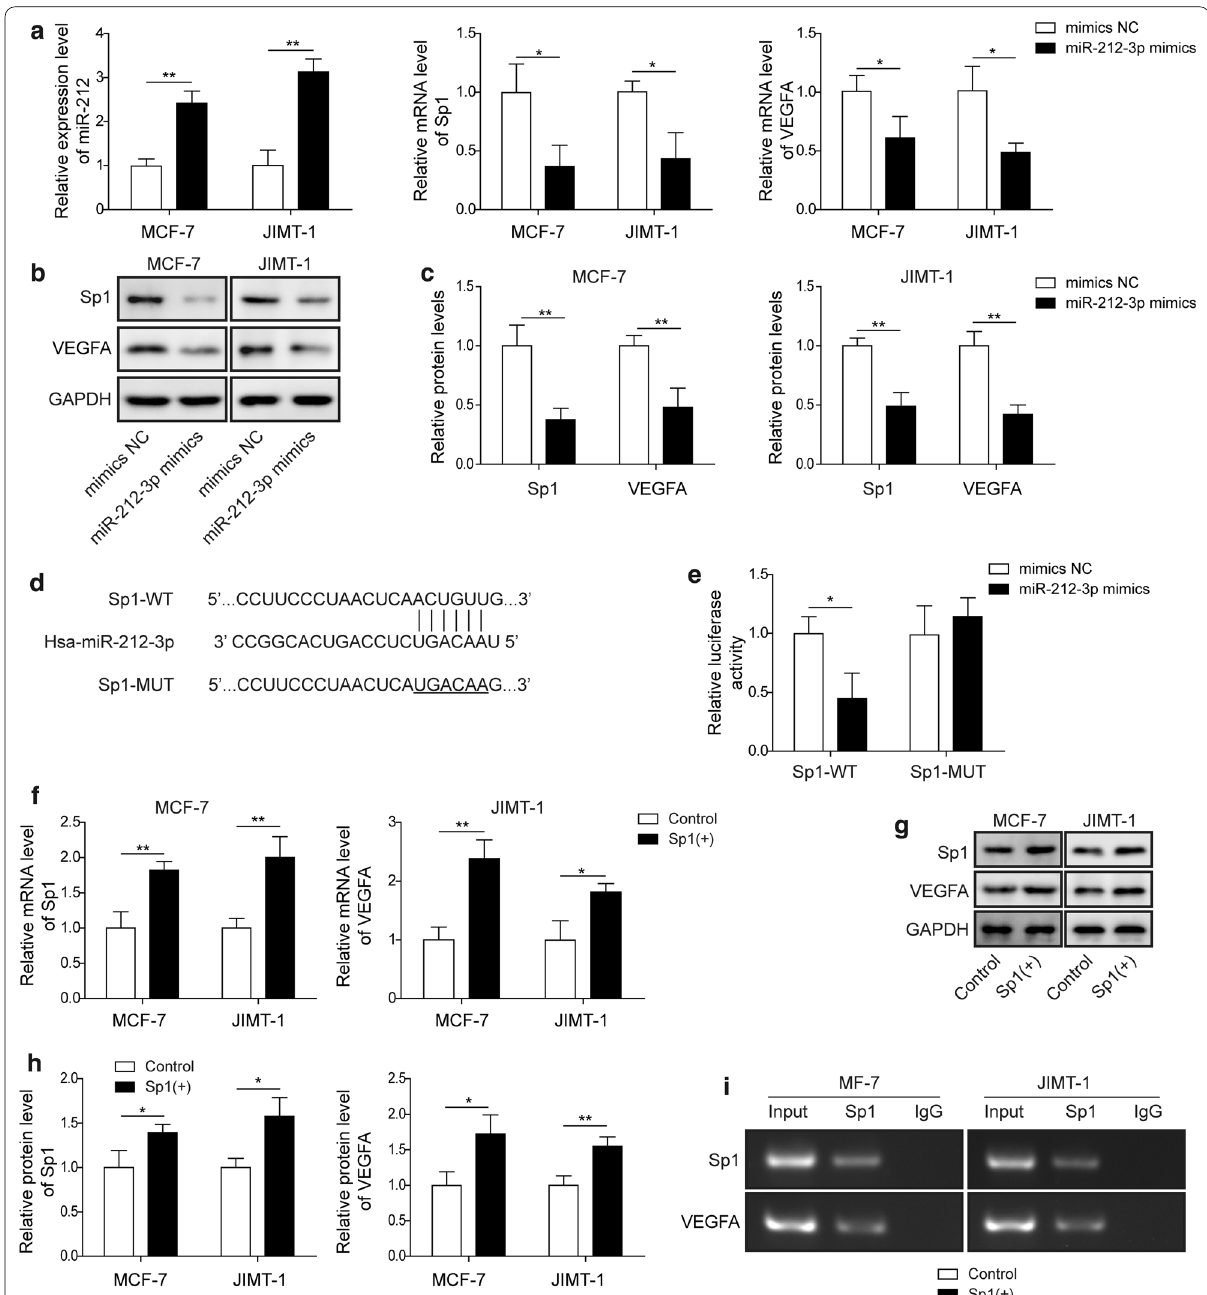
Fig. 3 MiR‑212‑3p reduces VEGFA expression through SP1. a QRT‑PCR detected expression level of miR‑212‑3p, Sp1 and VEGFA in MCF‑7 and JIMT‑1 after transfection of miR‑212‑3p mimics. b , c Western blot detected the protein level of Sp1 and VEGFA in MCF‑7 and JIMT‑1 after transfection of miR‑212‑3p mimics. d Binding site of miR‑212‑3p to Sp1. e Dual luciferase analysis of WT or MUT Sp1 in 293T cells transfected with miR‑212‑3p mimics. f QRT‑PCR detected Sp1 and VEGFA mRNA levels in MCF‑7 and JIMT‑1 after Sp1 overexpression. g , h Western blot detected Sp1 and VEGFA protein levels in MCF‑7 and JIMT‑1 after Sp1 overexpression. i ChIP analysis of Sp1 and VEGFA promoter. Relative intensity of bands of each protein in western blot were normalized to loading control GAPDH. * P < 0.05, ** P < 0.01, *** P <